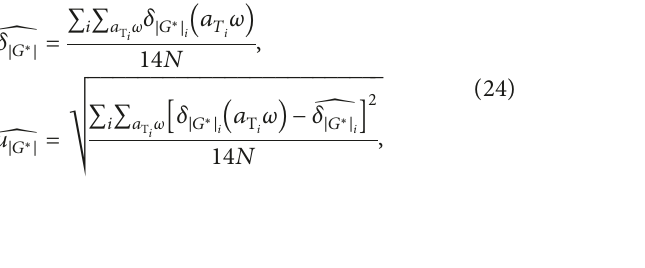
Figure 5: Errors between 2S2P1D simulations of all users and experimental data for the bitumen ( T (a), G 2 (b), and